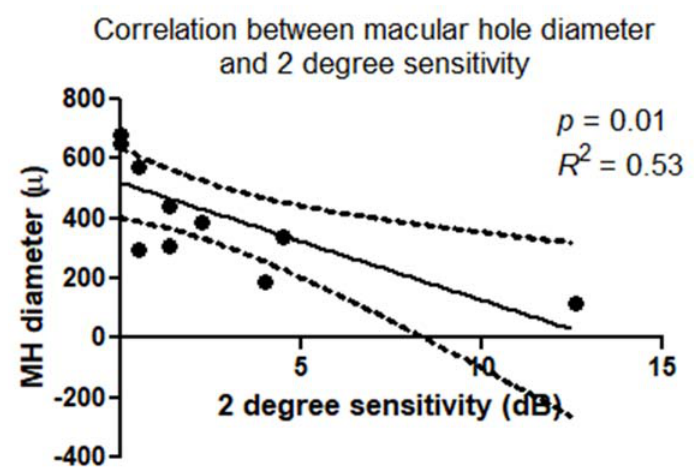
Figure 5. Scatterplot shows the statistically significant correlation ( p = 0.01; R 2 = 0.53) between macular hole diameter ( µ m) and microperimetry 2 degree sensitivity (dB).